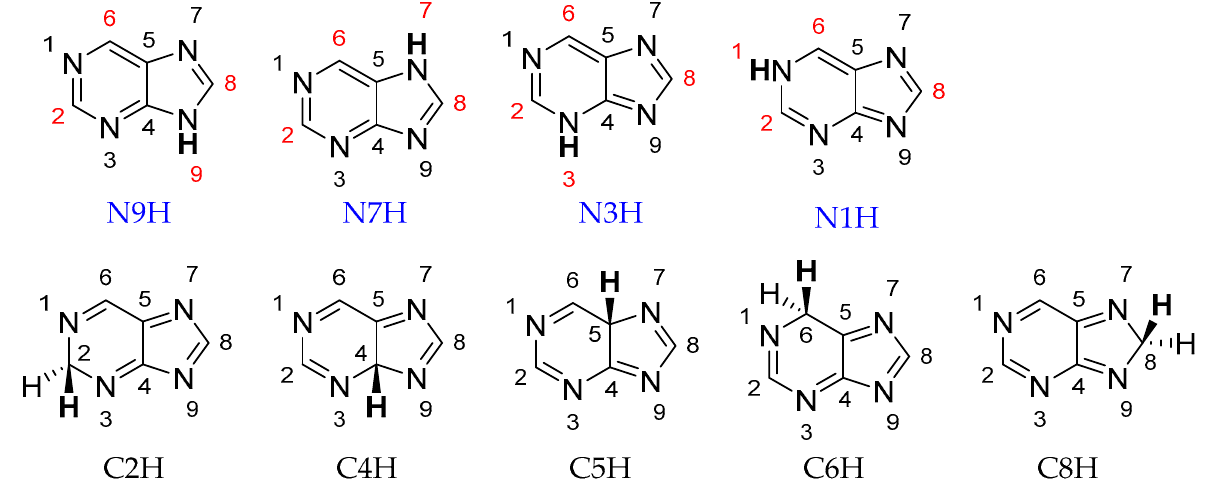
Scheme 1. Structures of nine prototropic purine tautomers. Mono-NH 2 -substituted derivatives of four N tautomers are the subject of this study. Substitution positions (C2-, C6-, C8-, and N-) are marked in